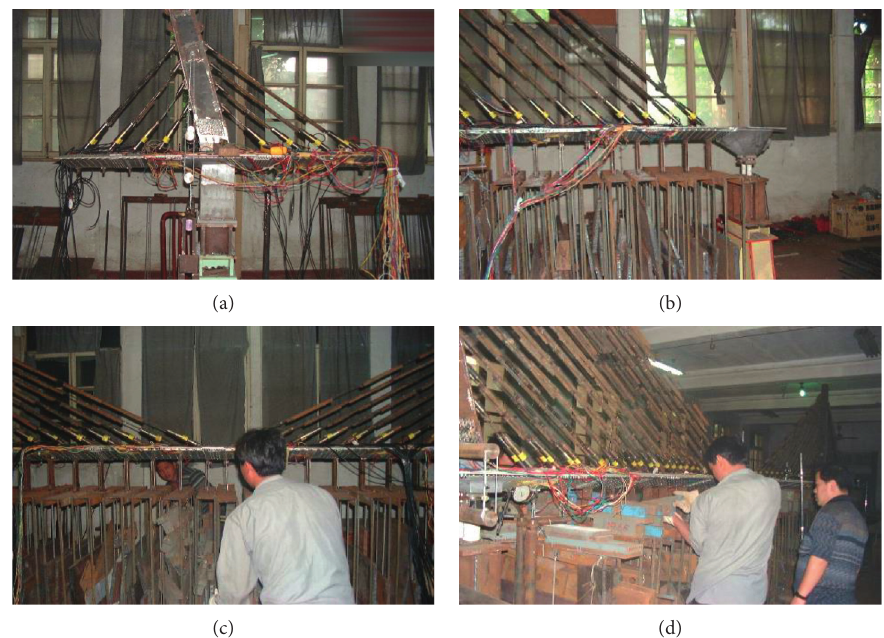
Figure 3: Installing the model: (a) installing four pairs of stay cables at Pier 4#, (b) closure of side span of Pier 5#, (c) second stage dead load applied by model, and (d) model exerts live load.